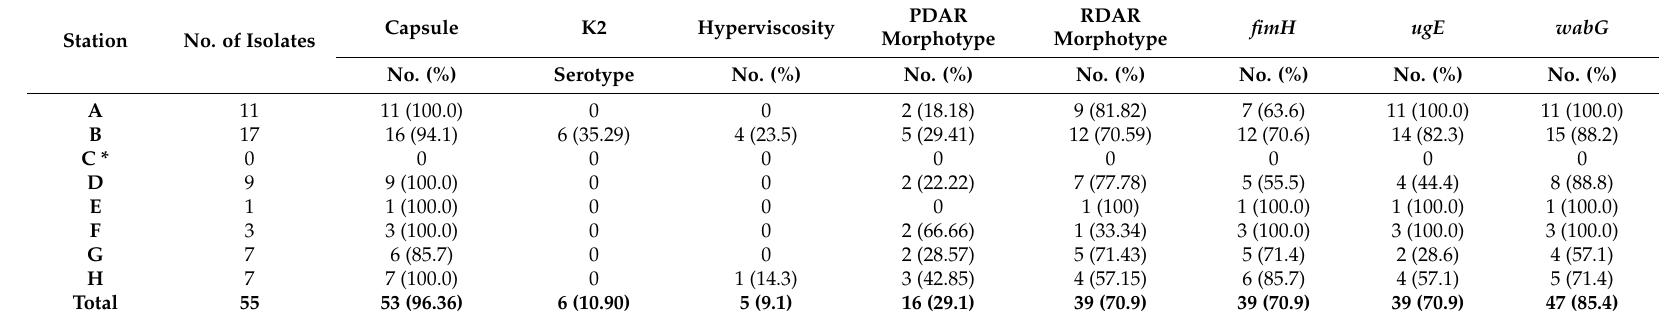
Table 2. Virulence properties of 55 isolated K. pneumoniae from the Matang mangrove estuary, Perak,